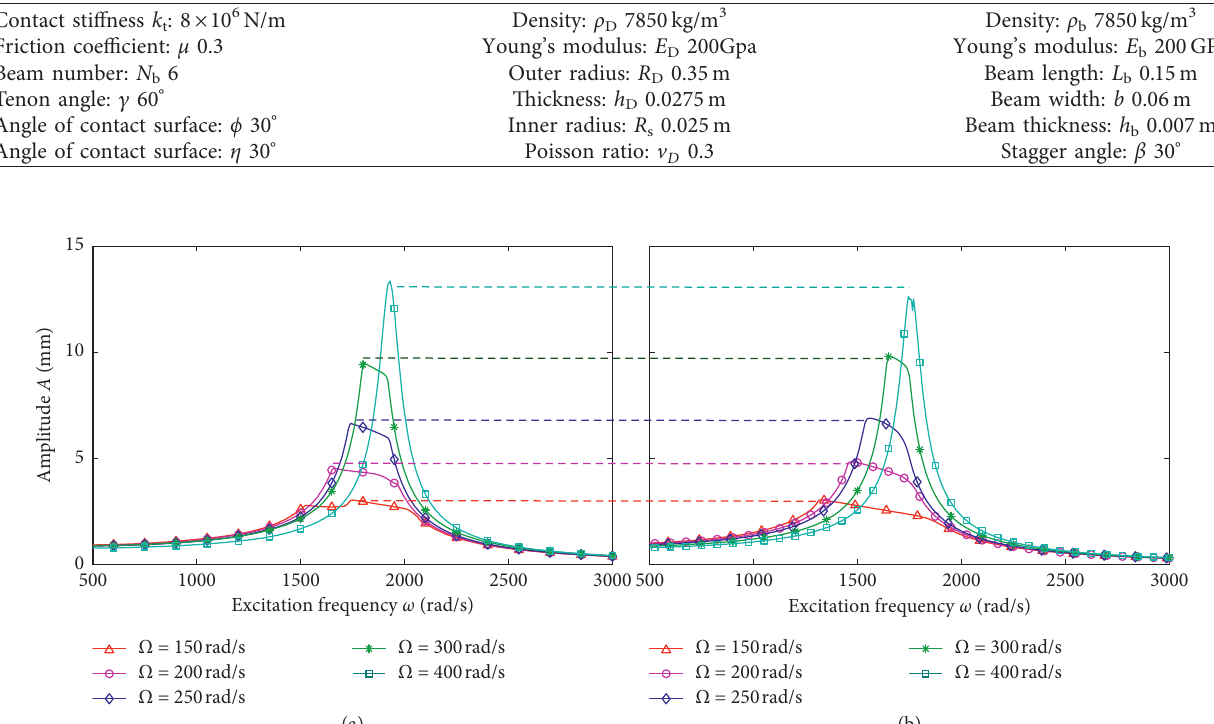
Figure 2: The structure diagram of the dry friction. Table 1: Model parameters of the coupled disk-beam system with the dovetail interface feature. Parameter